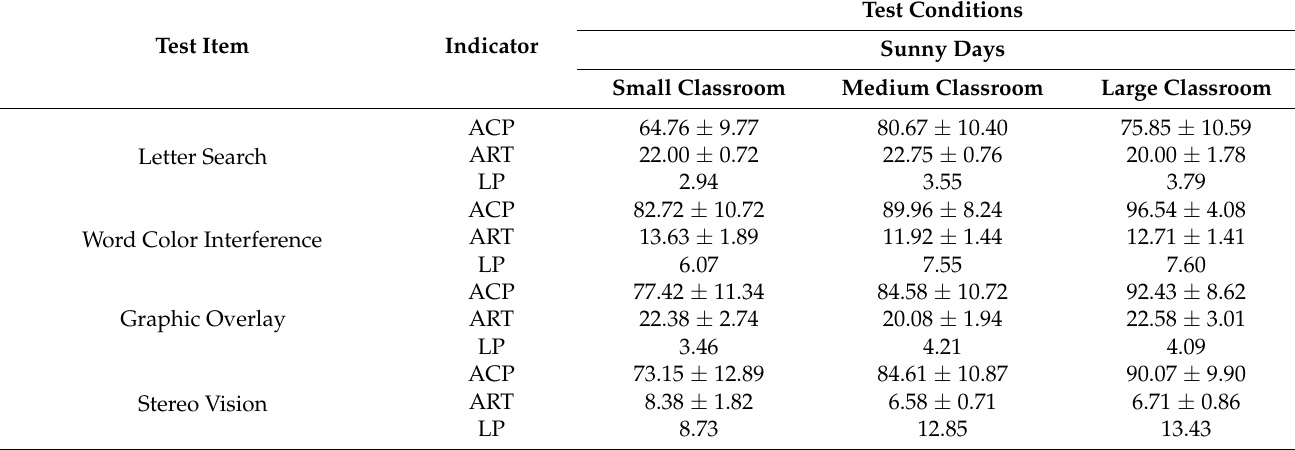
Table A5. The final results of the ACP, ART and LP of the relevant test items on sunny